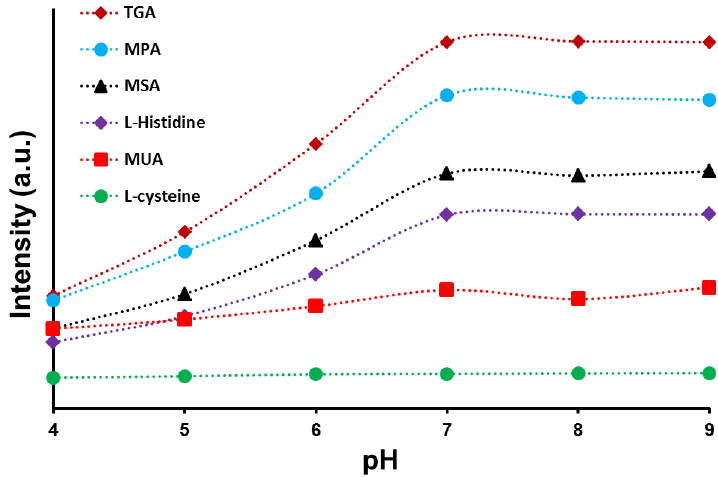
Figure 4. Fluorescence intensity for CdSe/ZnS QDs coated with different surface ligands of TGA, MUA, MPA, MSA, L -cystein, and L-histidine under different solution pH values.